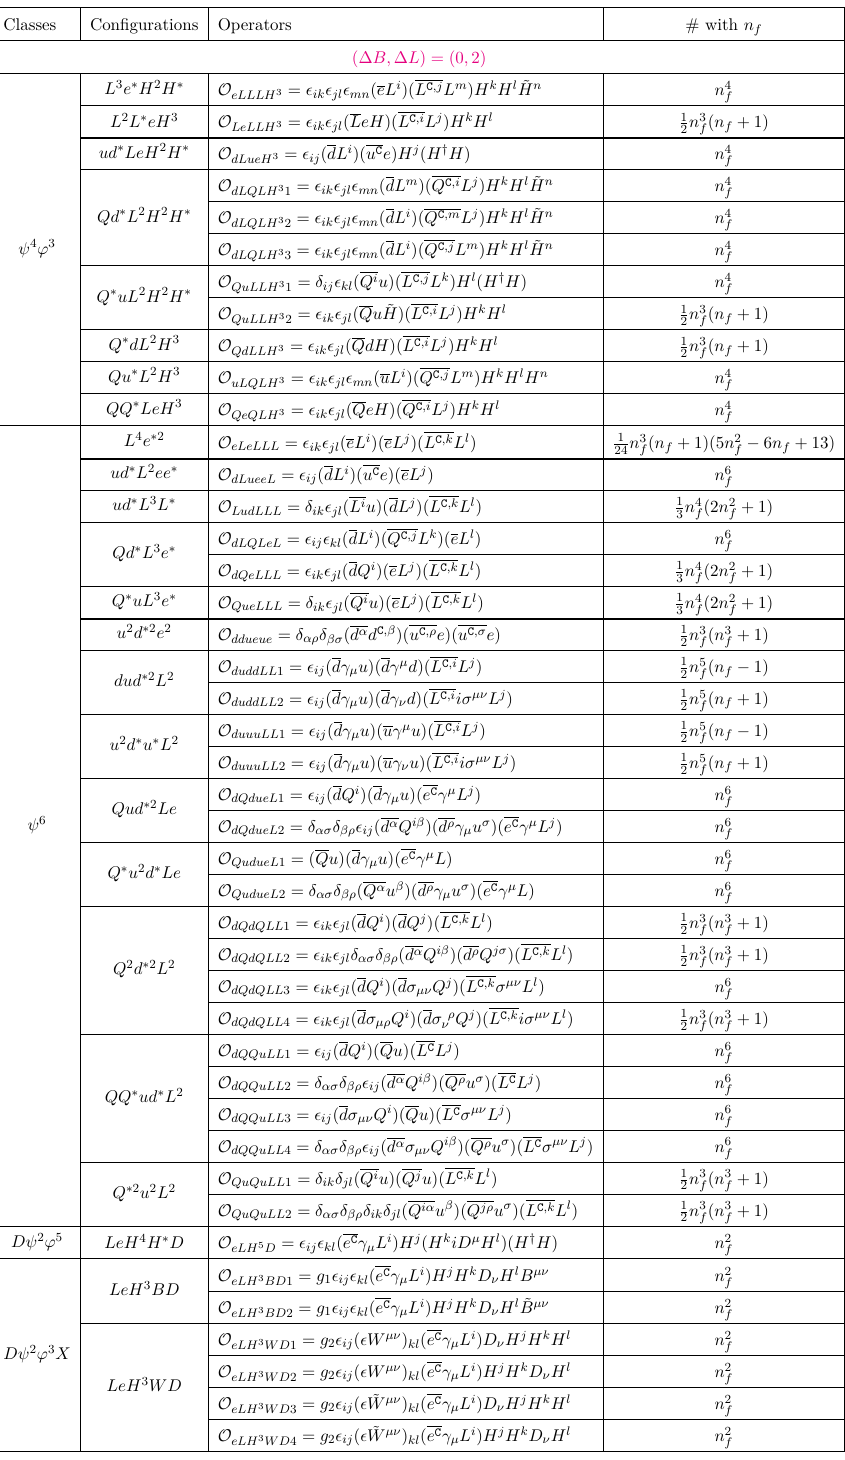
Table 3 . Dim-9 operators in classes ψ 4 ϕ 3 , ψ 6 , Dψ 2 ϕ 5 , Dψ 2 ϕ 3 X for sector (∆ B, ∆ L ) = (0 , 2) . There are 43 operators without counting fermion generations and 41 remain for one generation case. Hermitian conjugated operators are not included or